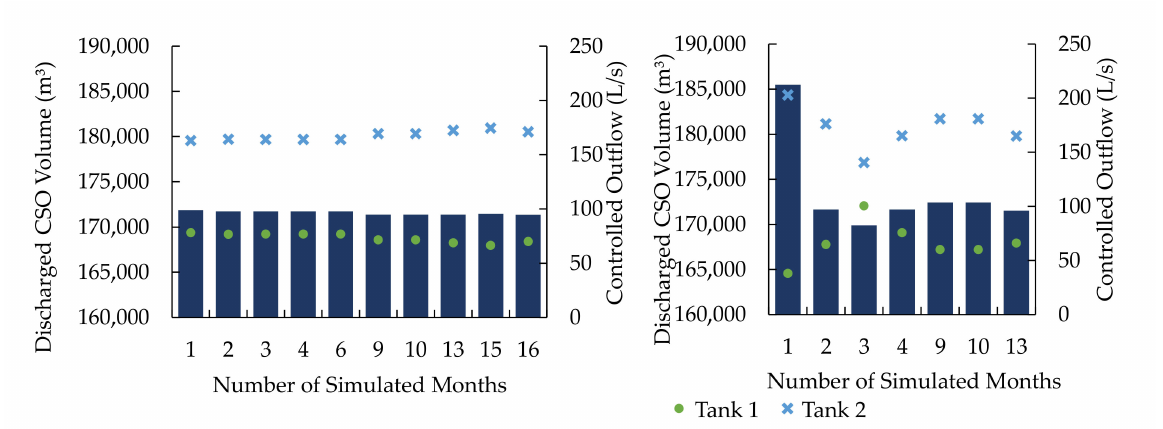
Figure 5. Influence of different durations of measured data on optimization results for volume (left) and load optimized controlled outflows (right).